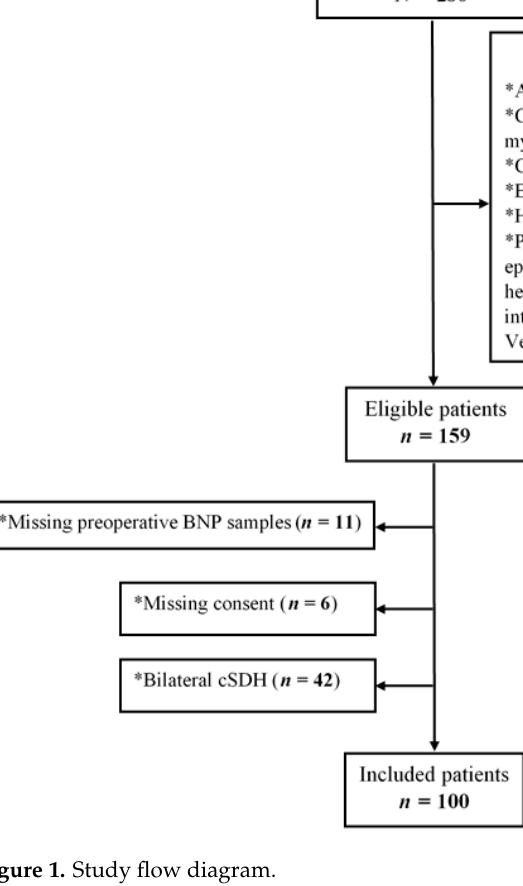
Figure 1. Study flow diagram.